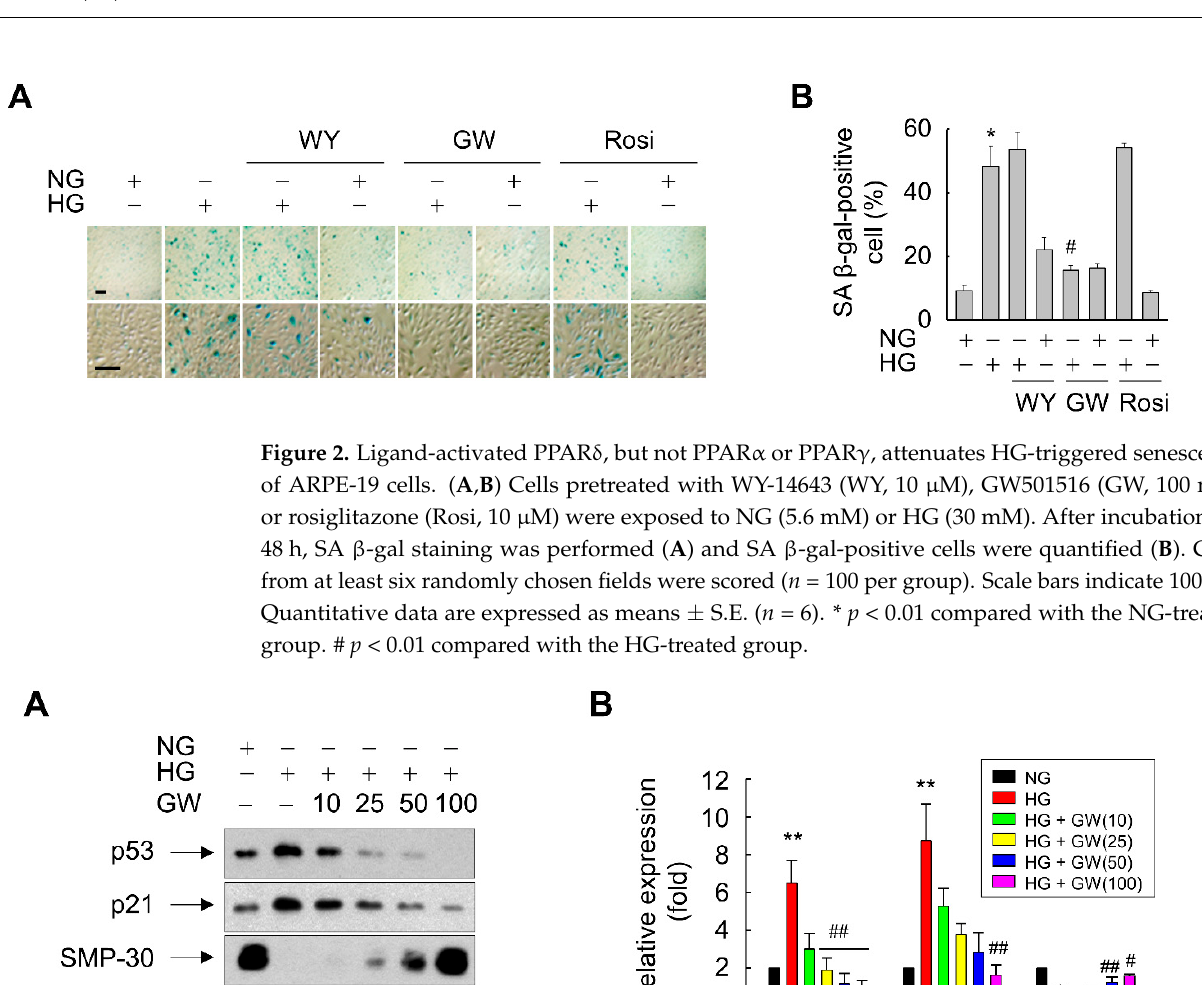
Figure 3. Ligand-activated PPAR δ regulates expression of the senescence-associated marker pro- teins p53, p21, and SMP-30 in ARPE-19 cells. ( A , B ) Cells pretreated with a vehicle (DMSO) or 10–100 nM GW501516 (GW) for 24 h were exposed to NG (5.6 mM) or HG (30 mM). After incubation for 48 h, whole-cell lysates were prepared and subjected to Western blot analyses. Representative images from three independent experiments are shown ( A ) and quantitative data ( B ) are presented as means ± S.E. ( n = 3). * p < 0.01, ** p < 0.05 compared with the NG-treated group. # p < 0.01, ## p < 0.05 compared with the HG-treated group.